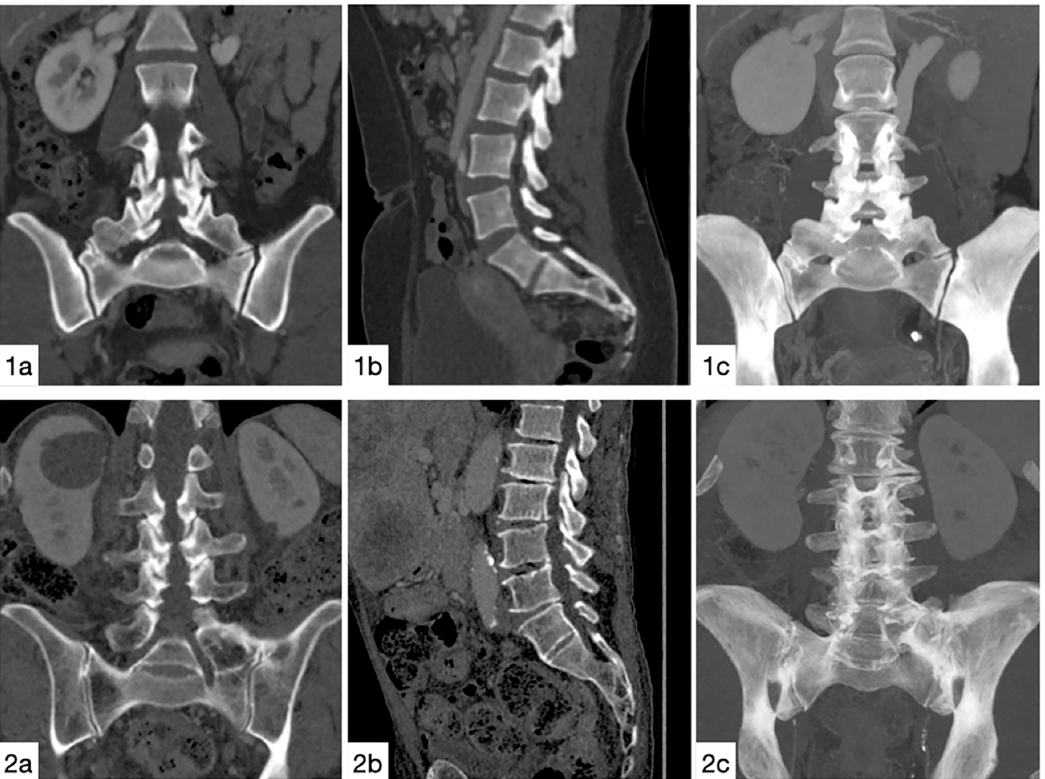
Figure 2. Imaging examples. Castellvi IIa: coronal ( 1a ) and sagittal ( 1b ) reconstructions, as well as 34 mm maximum intensity projection ( 1c ). Castellvi IIIb: coronal ( 2a ) and sagittal ( 2b ) reconstructions, as well as 34 mm maximum intensity projection ( 2c ).